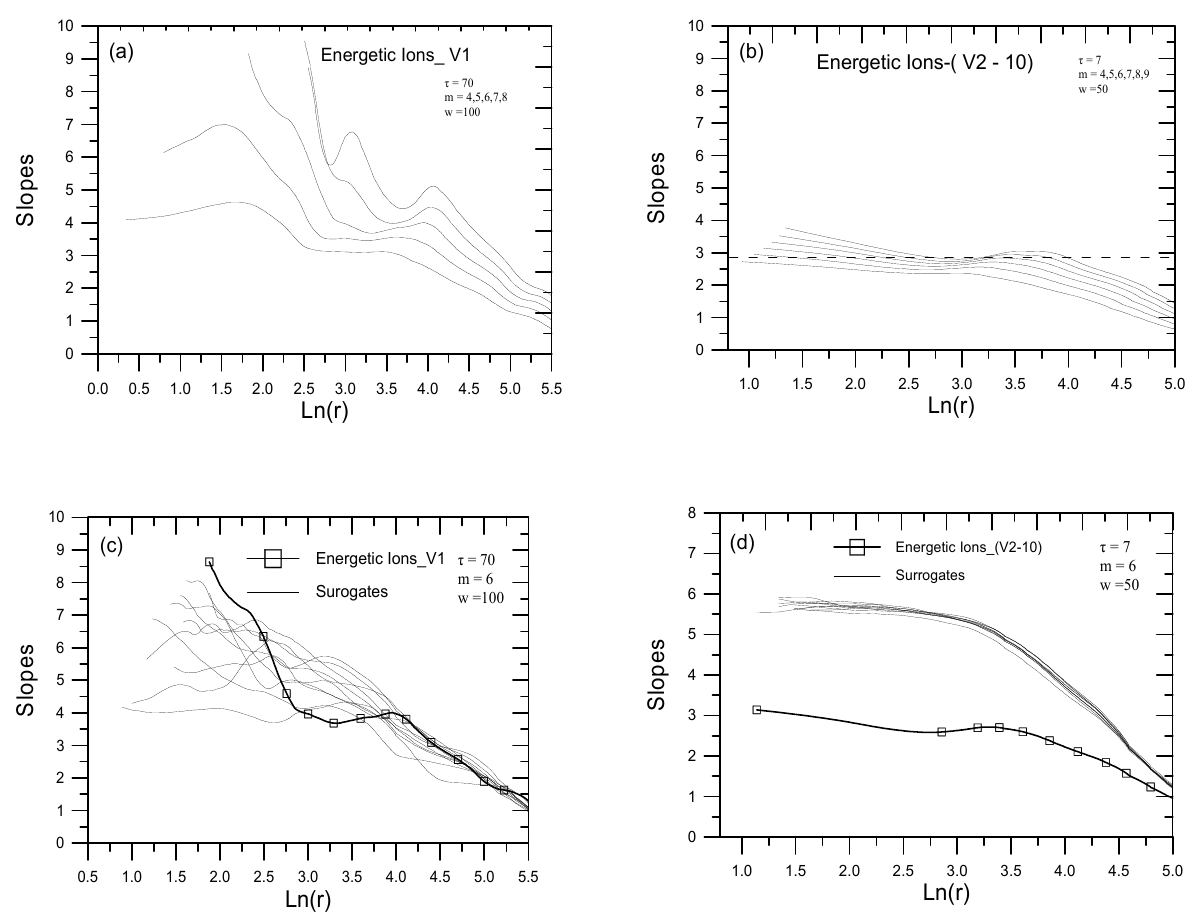
Figure 13 Fig. 13. (a) The slopes of the correlation integrals estimated for the V 1 SVD reconstructed component of the energetic ions time series for